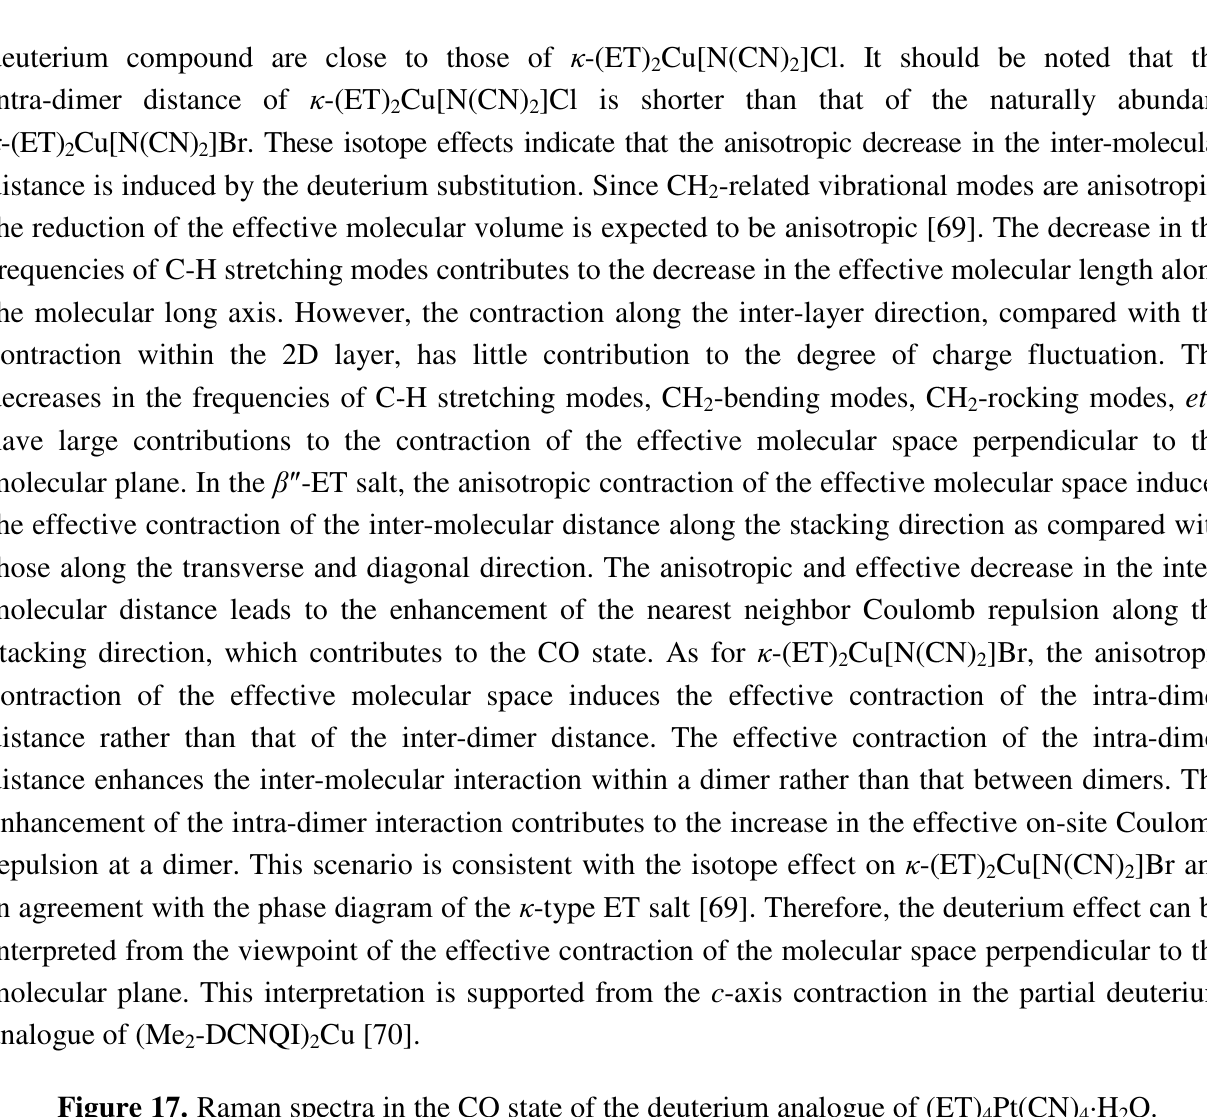
Figure 17. Raman spectra in the CO state of The incident light is irradiated onto the 2D layer. The spectra at 10 K is also shown in Figure 15. The laser energy is 780